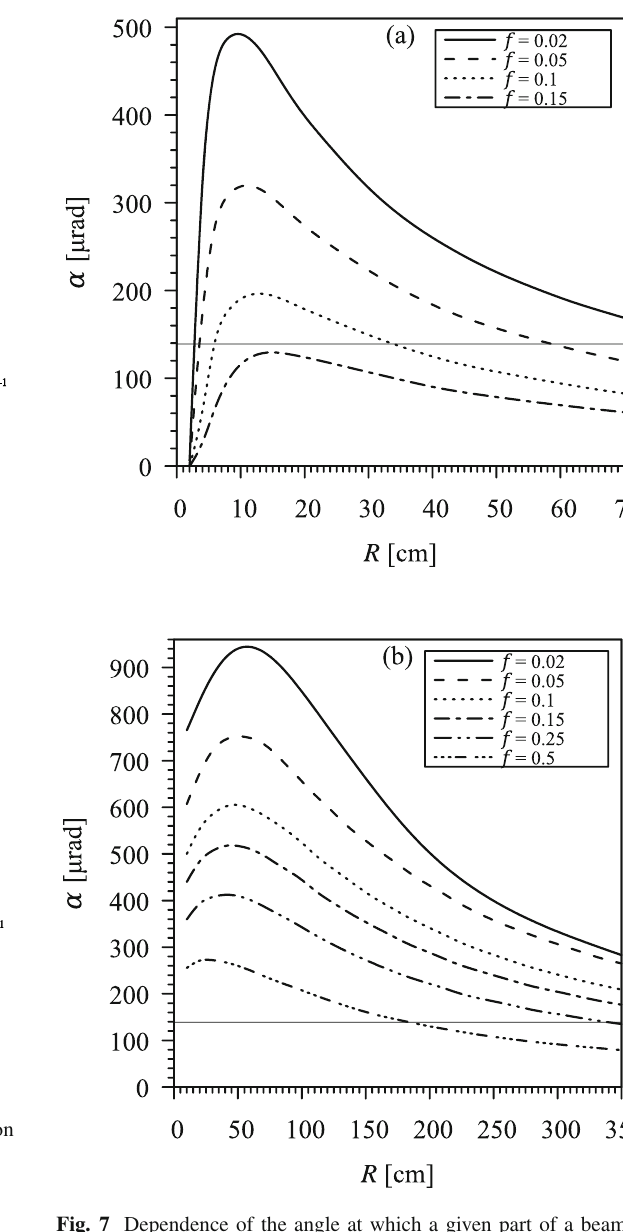
Fig. 7 Dependence of the angle at which a given part of a beam of antiprotons with a kinetic energy of 10 GeV can be deflected by means of planar channeling ( a ) and stochastic deflection ( b